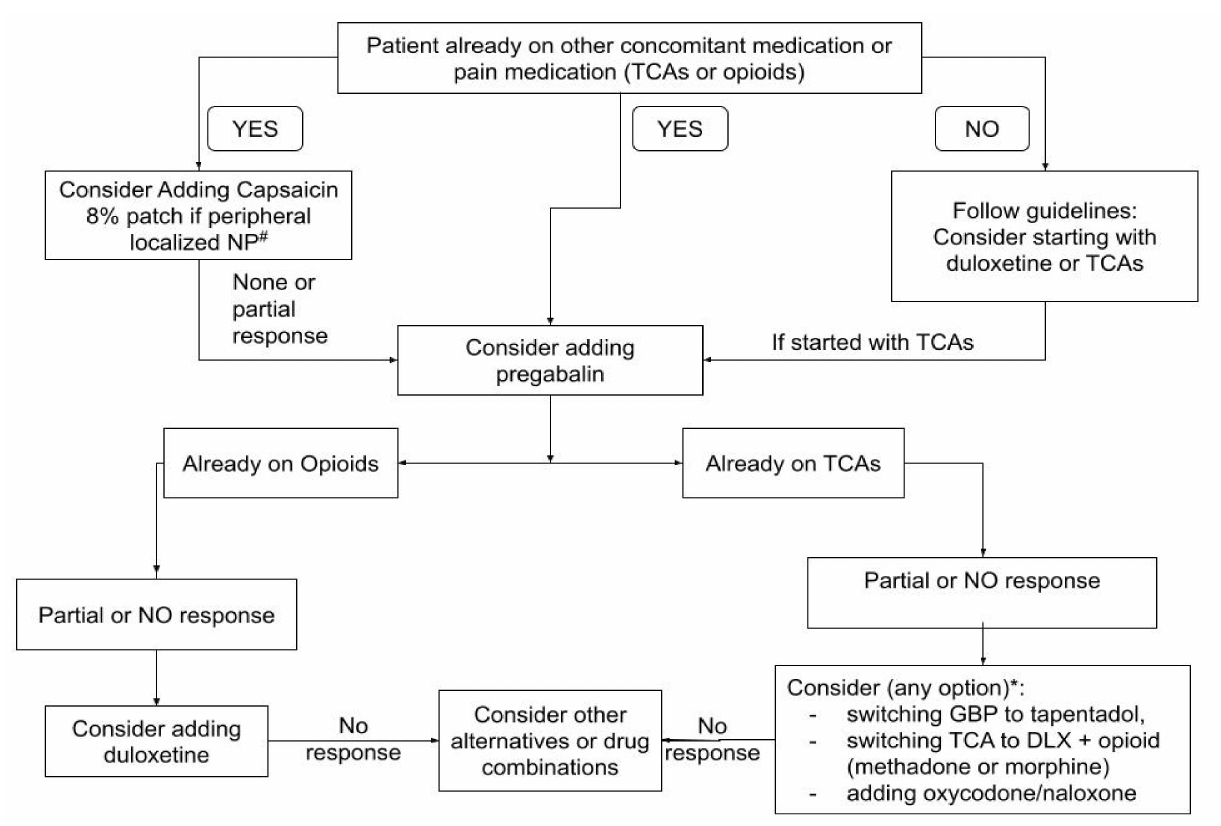
Figure 2. A guide presented as a flowchart for a strategy for combination therapy for neuropathic pain. This flowchart is a strategic proposal for prescribing combination therapy for neuropathic pain that begins with a patient already on opioids or tricyclic antidepressants. The option for those who are already on gabapentinoids or on duloxetine is not shown. Evidence in this regard is inconclusive and controversial. This flowchart is a proposal drawn from the recent evidence presented in this review. Clinicians should consider that this guide may (and should) change as new evidence is brought to light. # = While in this review we did not find published evidence on lidocaine patches, these should be considered where appropriate by previously published evidence. * = Evidence on opioid combination therapy is controversial and inconclusive. From recent evidence, these seem to be the best available options. TCAs = tricyclic antidepressants, NP = neuropathic Pain, DLX =